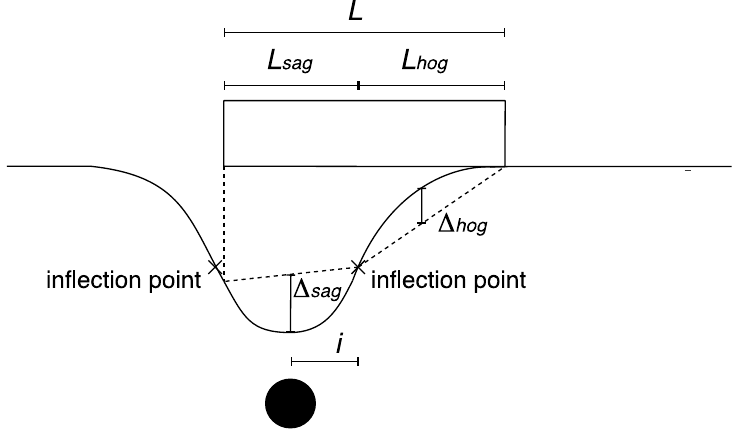
Figure 2. Typical shape of a tunneling-induced settlement trough. The inflection point separates the sagging (sag) from the hogging (hog) zone. The relative deflection and building length for each zone are indicated with ∆ and L .